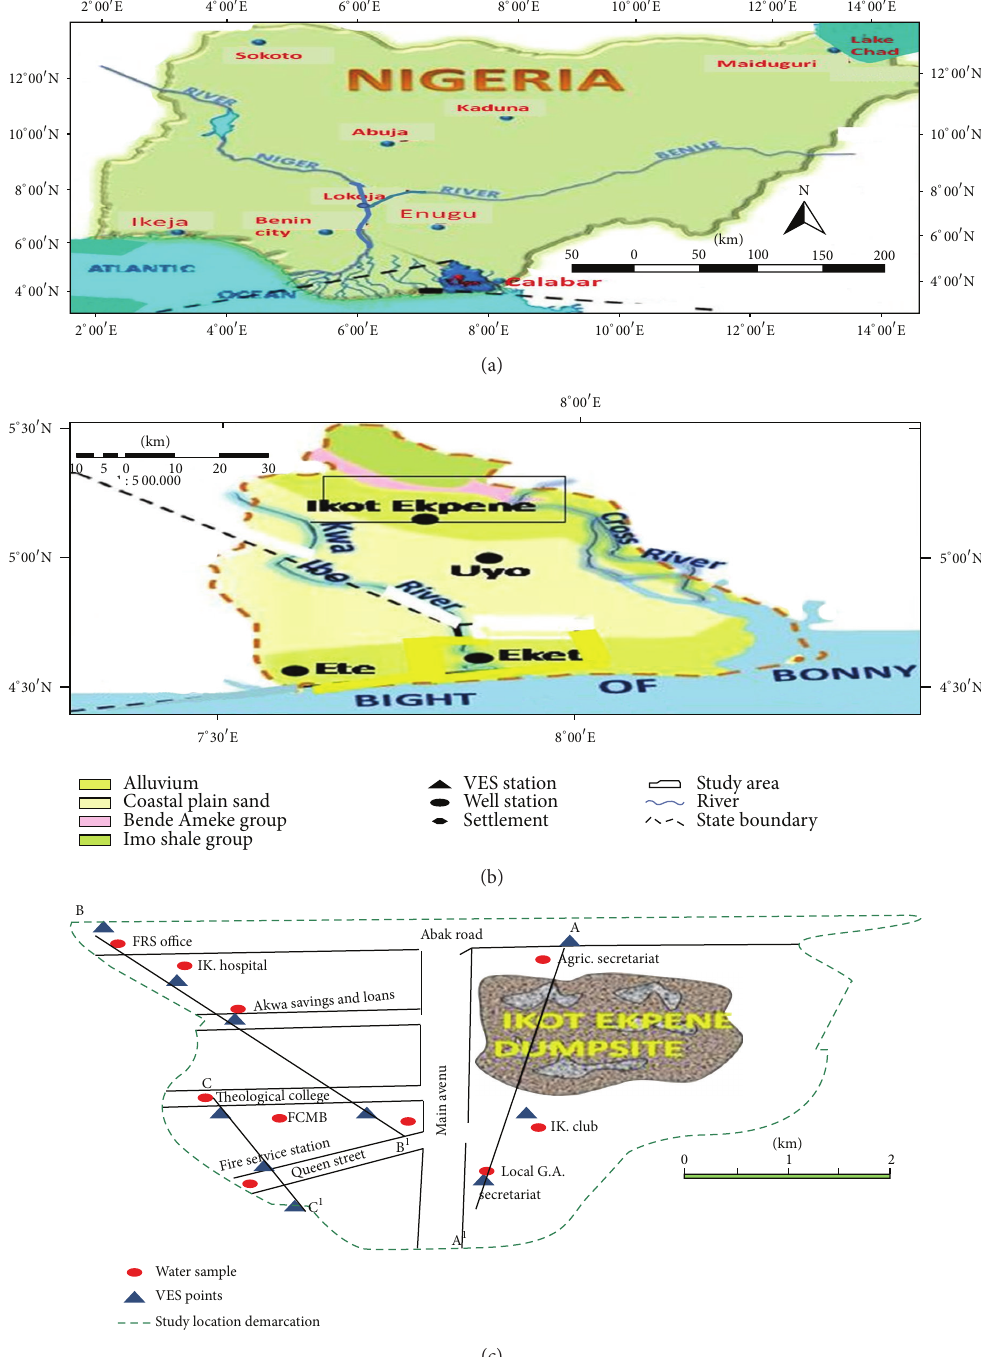
Figure 1: Outline map of (a) Nigeria showing the position of Akwa Ibom State, (b) map of the study area showing some of the LGAs and the generalized geology, and (c) sketch map of the dumpsite location and its environ, showing the VES profiles, boreholes, and VES location.